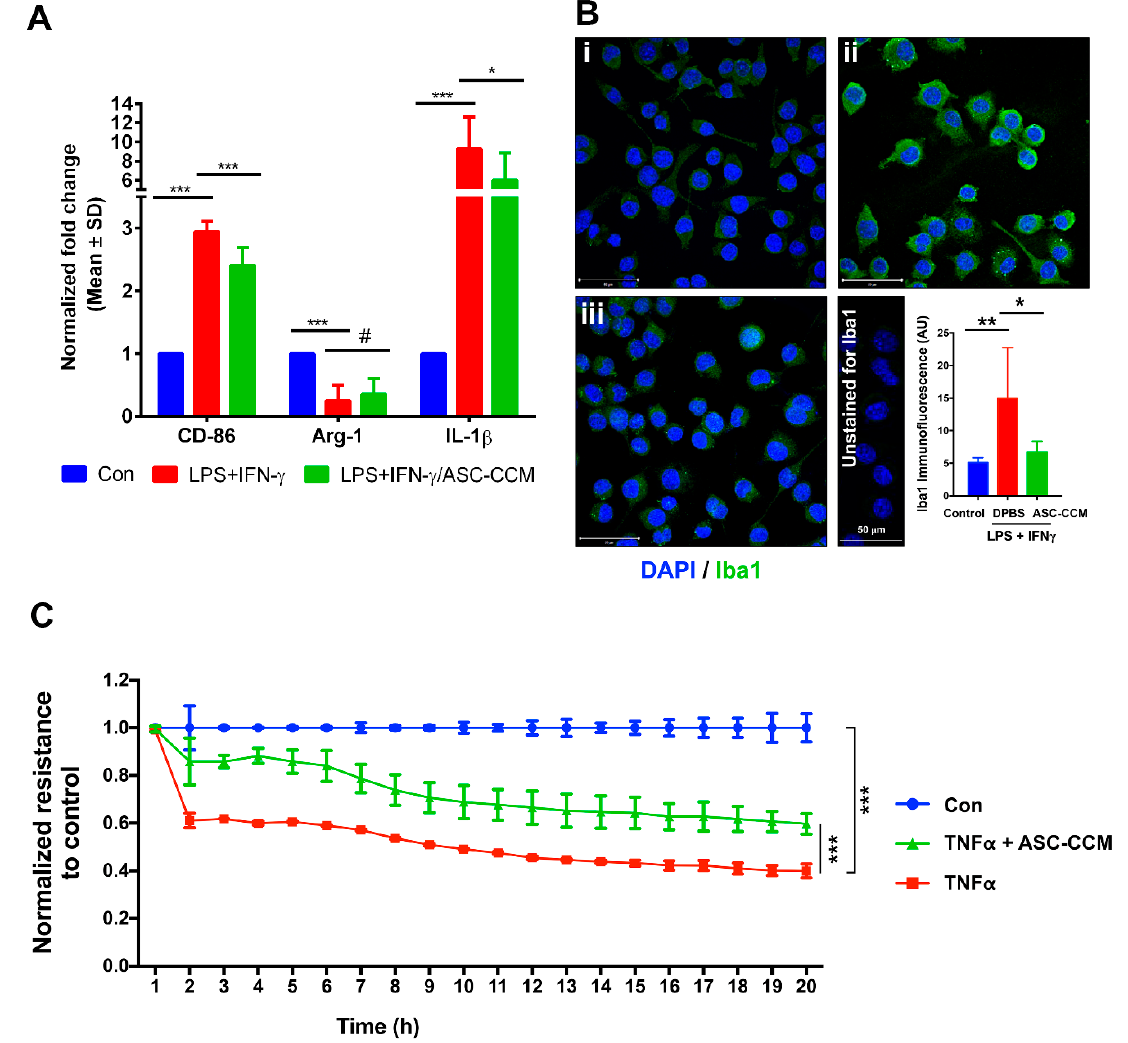
Figure 2. ASC-CCM suppresses microglial activation and improves trans-endothelial resistance. ( A ) ASC-CCM suppresses the LPS (100 ng/mL) and IFN γ (10 ng/mL) induced pro-inflammatory gene expression of BV2 cells. Assessment of gene expression by Sybr Green qPCR and expressed as fold change normalized to internal control (GAPDH) in the study groups. Data represent Mean ± SD from three separate experiments performed in duplicate. *, p < 0.05; ***, p < 0.001; #, p > 0.05. ( B ) ASC-CCM reduces microglial activity as shown by the decreased Iba1 immunoreactivity with LPS and IFN γ stimulated BV2 cells after 12 h exposure. Bar graph shows quantification of mean fluorescence intensity of Iba1. Data are Mean ± SD performed in duplicates. *, p < 0.05; **, p < 0.01. Scale bar = 50 μ m. ( C ) Trans-endothelial resistance is protected by ASC-CCM in vitro. Representative electric cell-substrate impedance-sensing (ECIS) tracings plotted as normalized resistance expressed as Mean ± SD of single experiment performed in replicates with similar data from two independent experiments. ***, p < 0.001.